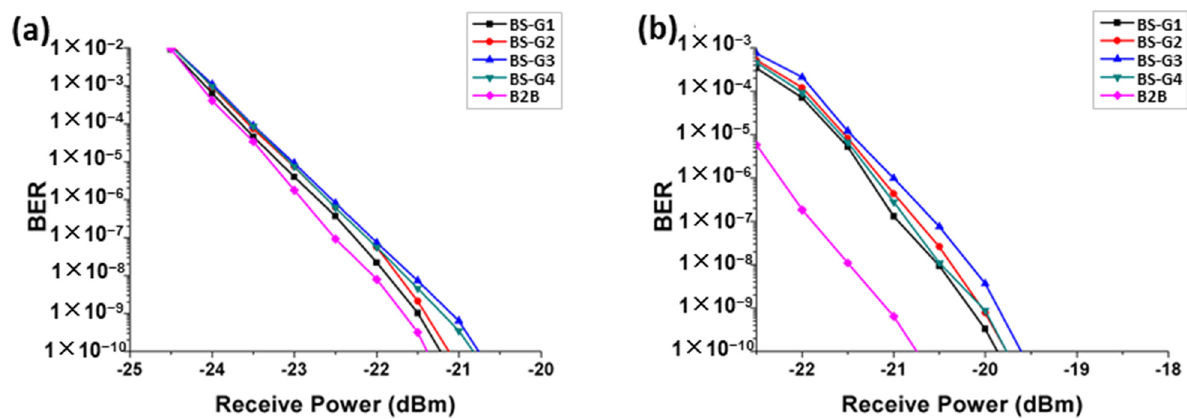
Figure 12. ( a ) Downlink RoF signal error rate performance measured in BS-Group1, BS-Group2, BS-Group3, BS-Group4, and Back-to-Back when a breakpoint occurs. ( b ) Uplink RoF signal error rate of BS-Group1, BS-Group2, BS-Group3, BS-Group4, and Back-to-Back measured at the CO end when a breakpoint occurs.